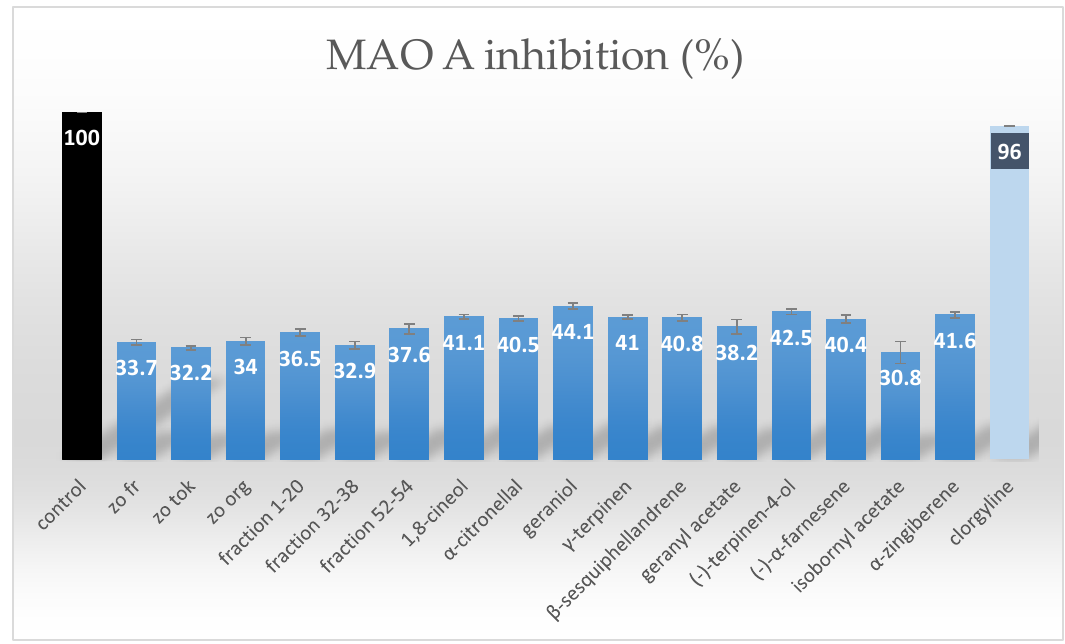
Figure 4. The percentage of MAO-A inhibition with standard deviation (SD) obtained for different ginger extracts (zo fr, zo tok, zo org), selected fractions from column 1 (fraction 0–20, 32–38 and 52–54) and purified terpenes (Control—MAO-A assay performed without any inhibitor shows the maximum of luminescence; clorgyline—the inhibition of a known inhibitor based on the MAO-A assay producer’s information in the same